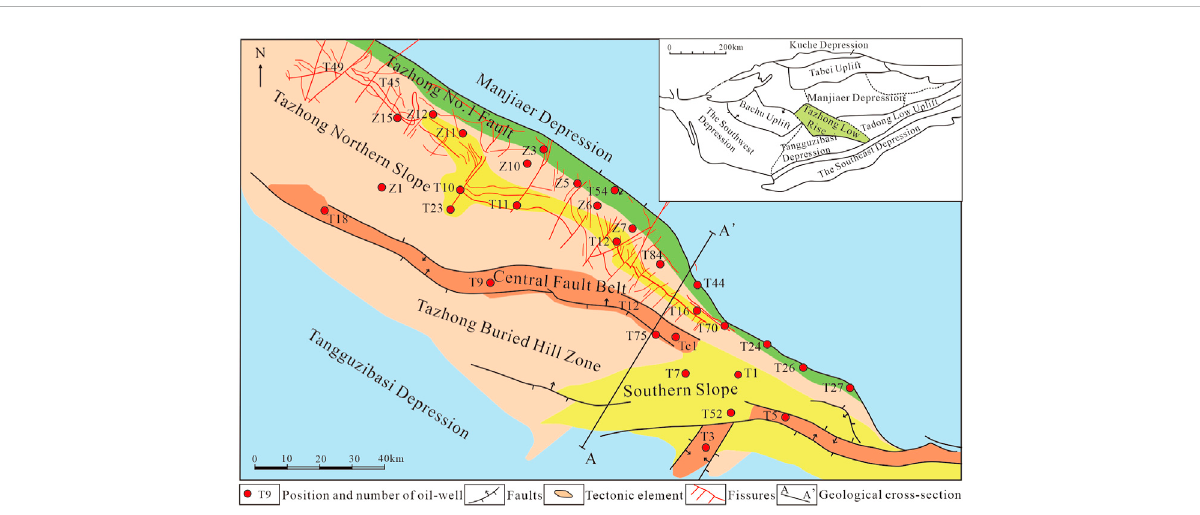
FIGURE 1 Geological map of tectonics and distribution of sampled wells within the Tazhong region of the Tarim basin.